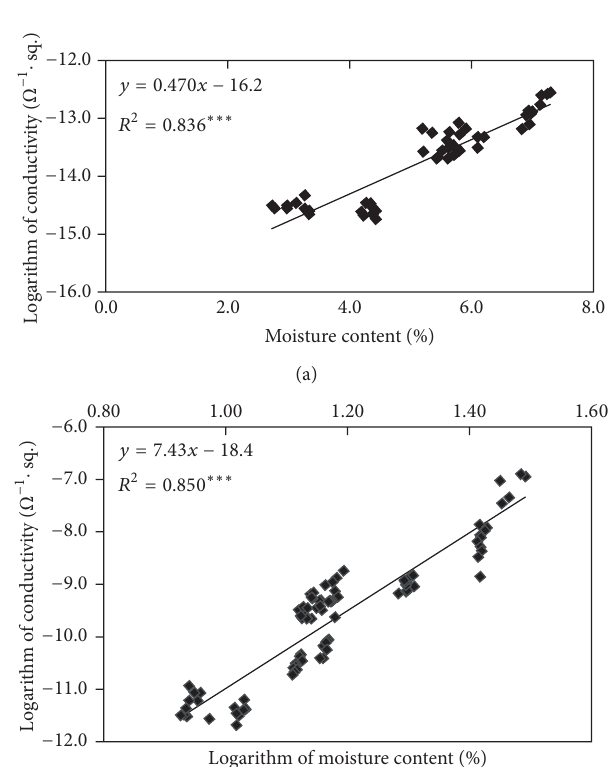
Figure 4: Relation between conductivity and moisture content. (a) Standard curve for logarithm of surface electrical resistivity versus MC below 8% for 63 specimens. 𝑥 -axis represents moisture content and 𝑦 -axis represents logarithm of surface electrical resistivity. (b) Standard curve for logarithm of surface electrical resistivity versus logarithm of MC above 8% for 97 specimens. 𝑥 -axis represents logarithm of moisture content and 𝑦 -axis represents logarithm of surface electrical